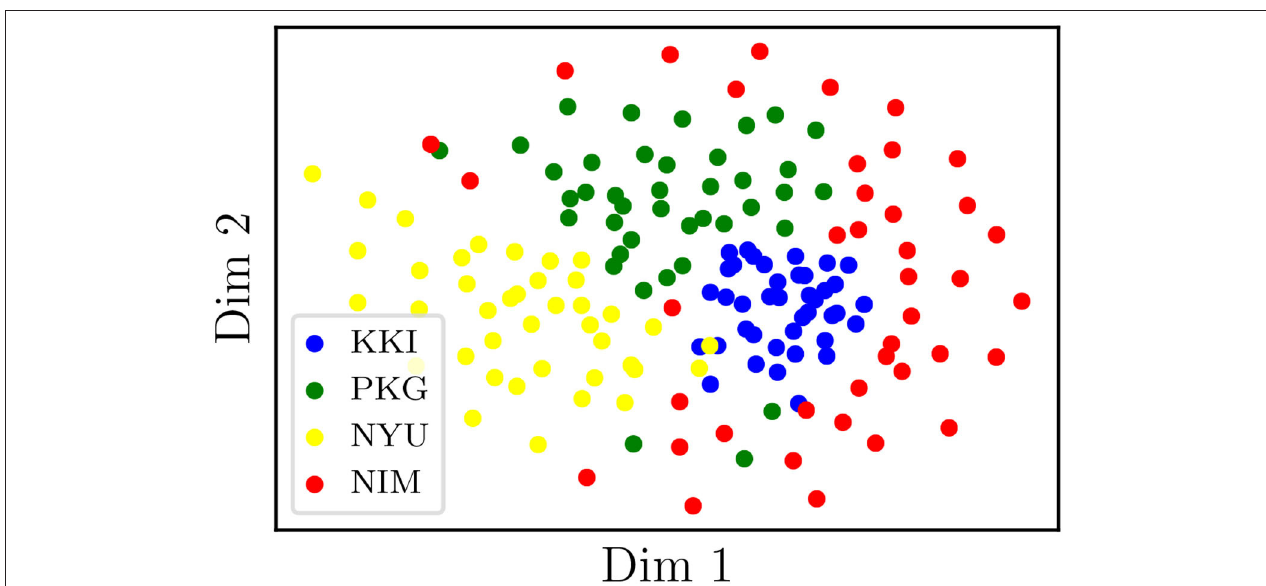
FIGURE 3 | Two-dimensional embedding obtained after applying t-stochastic neighbor embedding to the logarithms of non-harmonized matrices. KKI, Kennedy Krieger Institute, Johns Hopkins University; NYU, New York University Child Study Center; PKG, Peking University; NIM, NeuroIMAGE sample.